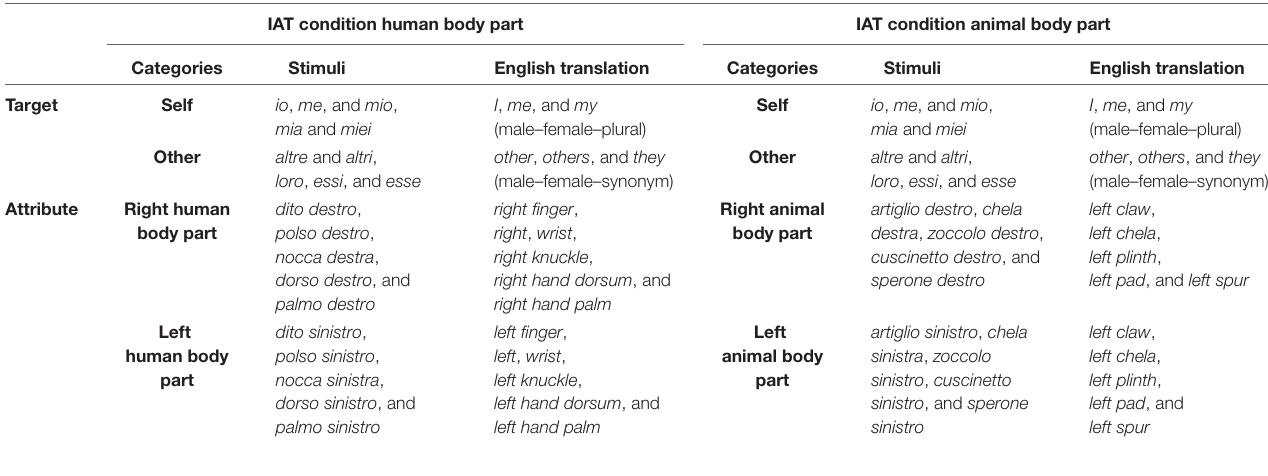
TABLE 1 | The original stimuli (in Italian) and their English translations are reported for each IAT Condition and